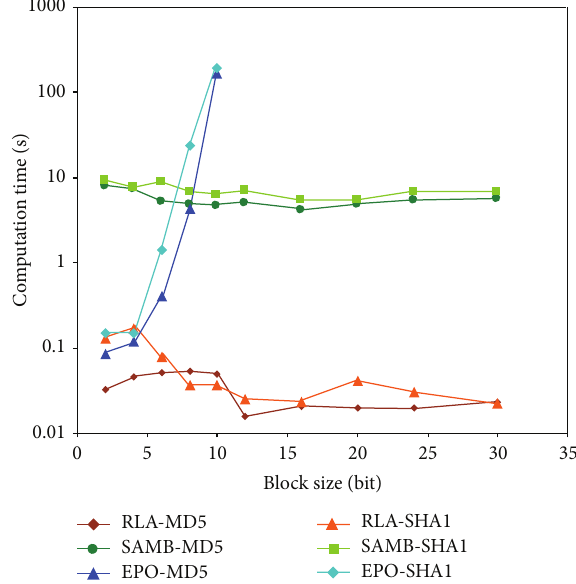
Figure 3: HDA for RLA and SAMB algorithms.